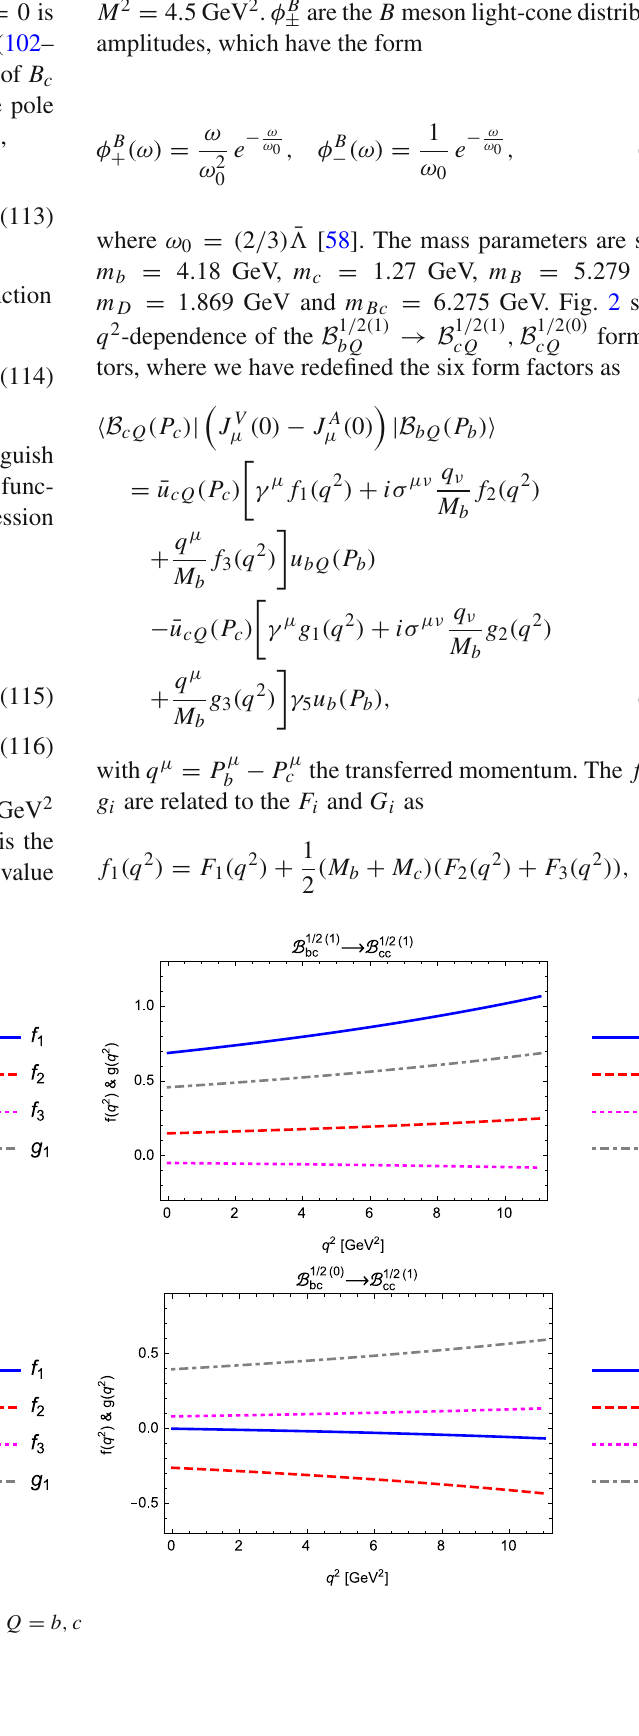
/ 2 → B 1 / 2 form factors, where Q = b , bQ cQ